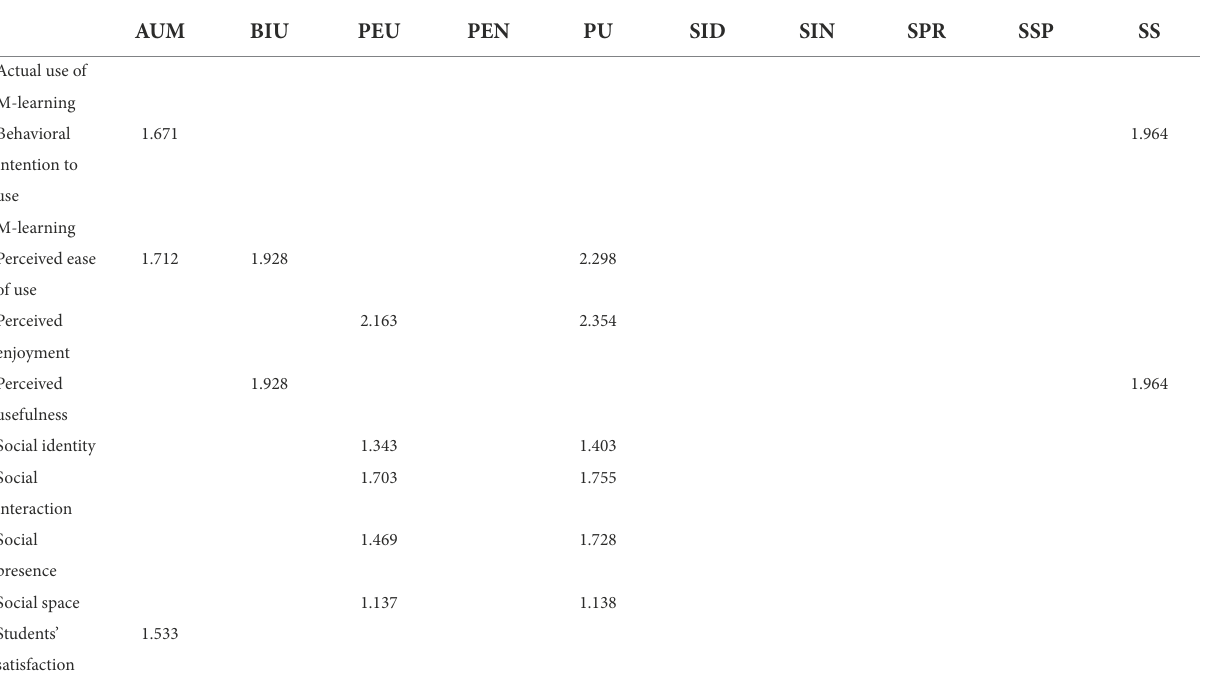
TABLE 5 Collinearity evaluation between the predictor constructs by inner VIF